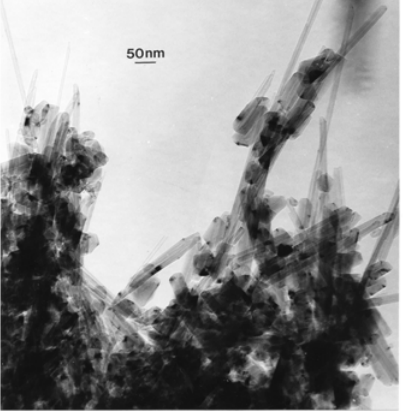
Figure 3: TEM image of MWCNT and multiconcentric fullerenes produced by injecting fine tire powder into an electric arc in helium.